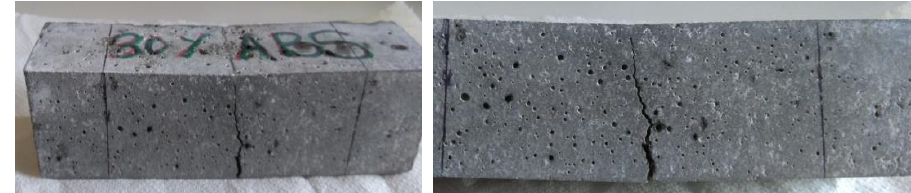
Figure A1. Facies of rupture: example of broken sample (30%v ABS).